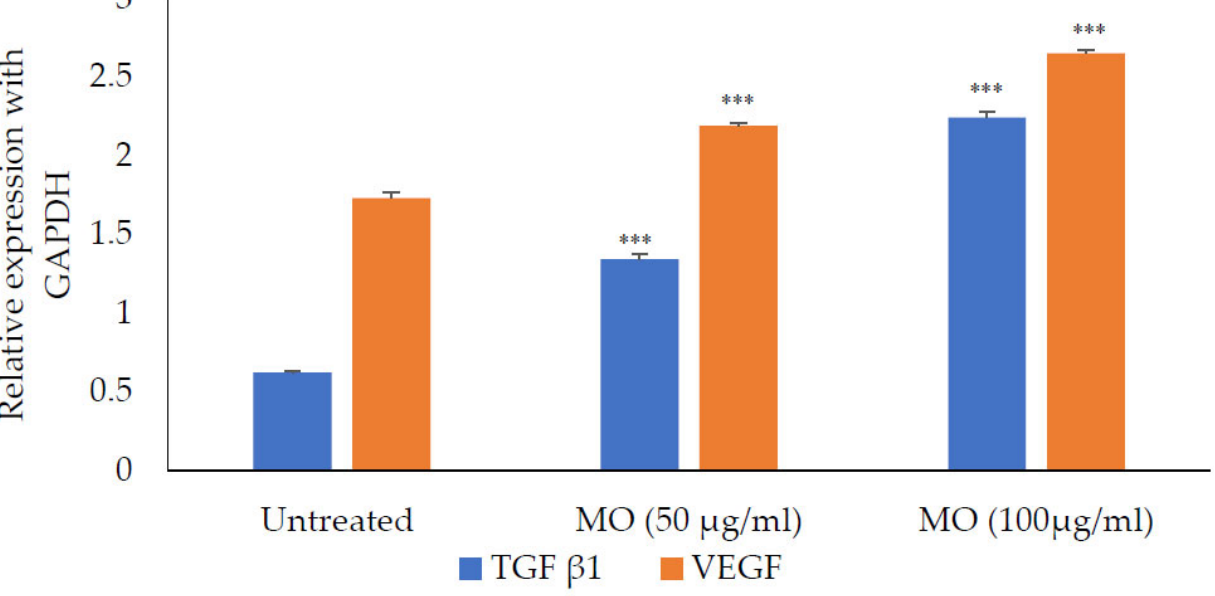
Figure 14. Effect of M. oleifera extract on the cell viability of human keratinocytes (HaCaT) cells. All values are mean ± SEM, n = 6.